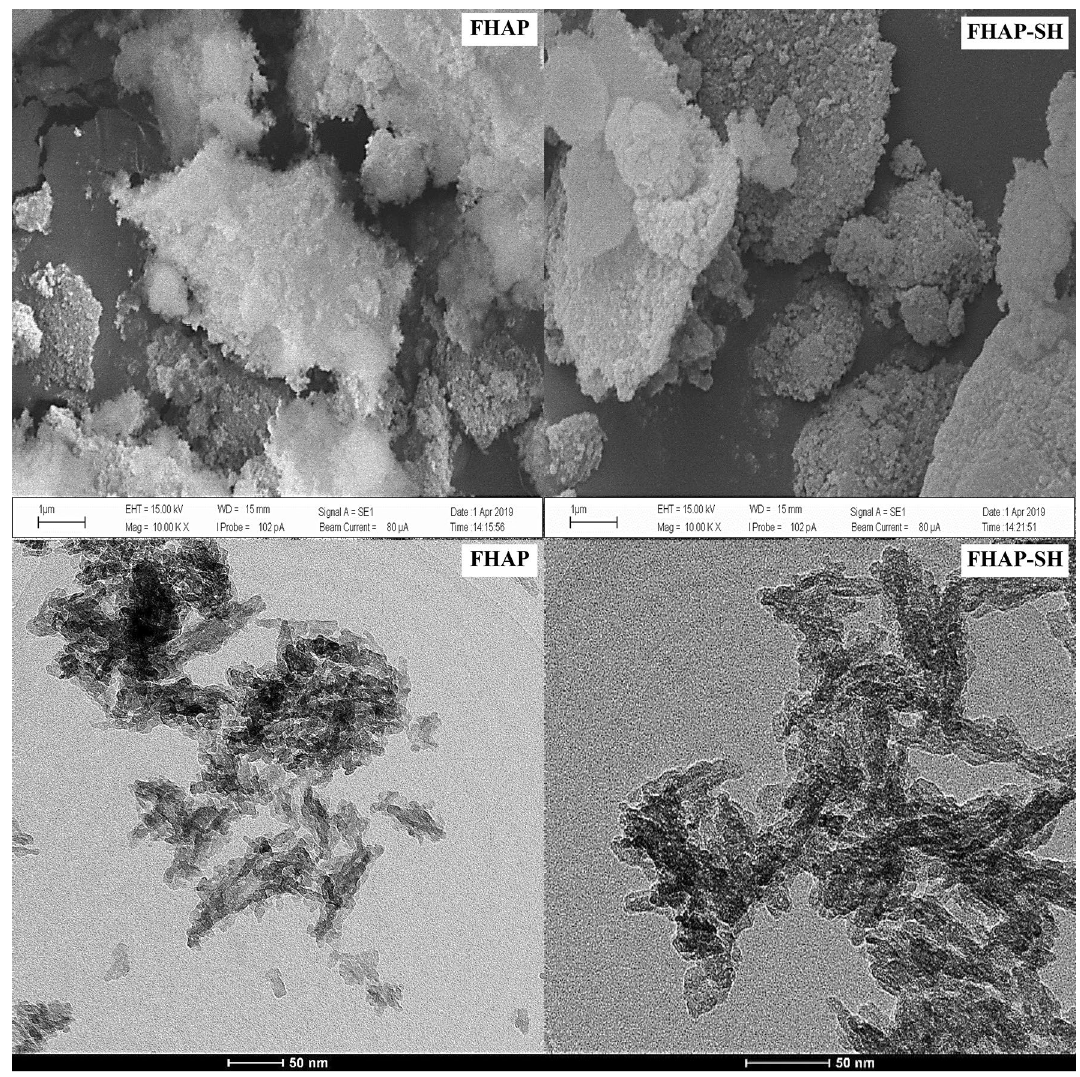
Figure 4. SEM and TEM images of the FHAP and FHAP-SH.